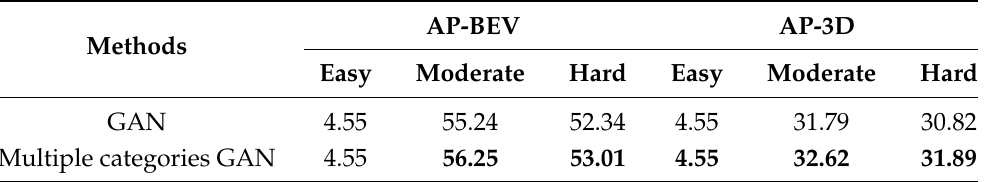
Table 3. Performance of the object detection for different type of